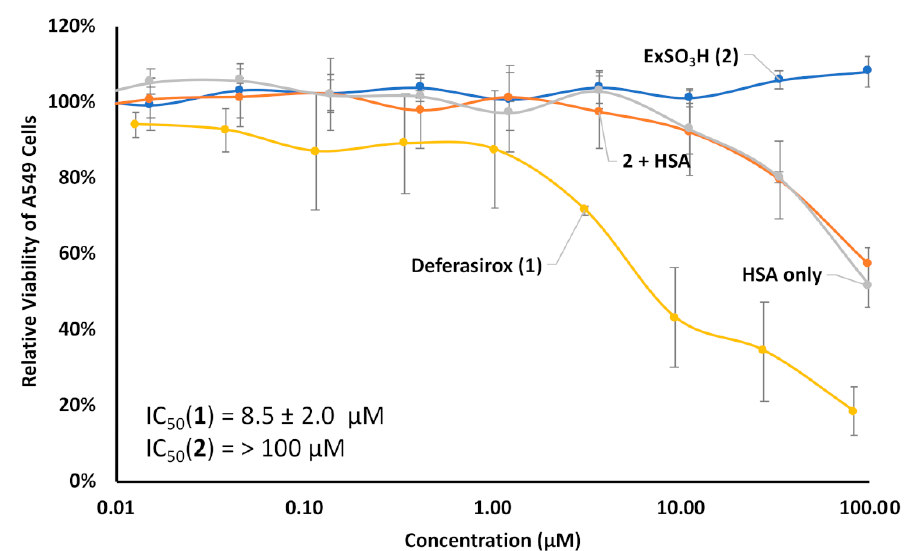
Figure 10. Cytotoxicity studies of 1 and 2 conducted in A549 cells grown in RPMI 1640 media at pH 7.2. Experiments were performed in triplicate with error bars indicating the standard deviation at each datum point. Cells were treated with different concentrations of 1 , 2 and 2 pre-combined with human serum albumin (HSA), respectively, and viability was determined after an exposure time of 72 h via MTT assay.